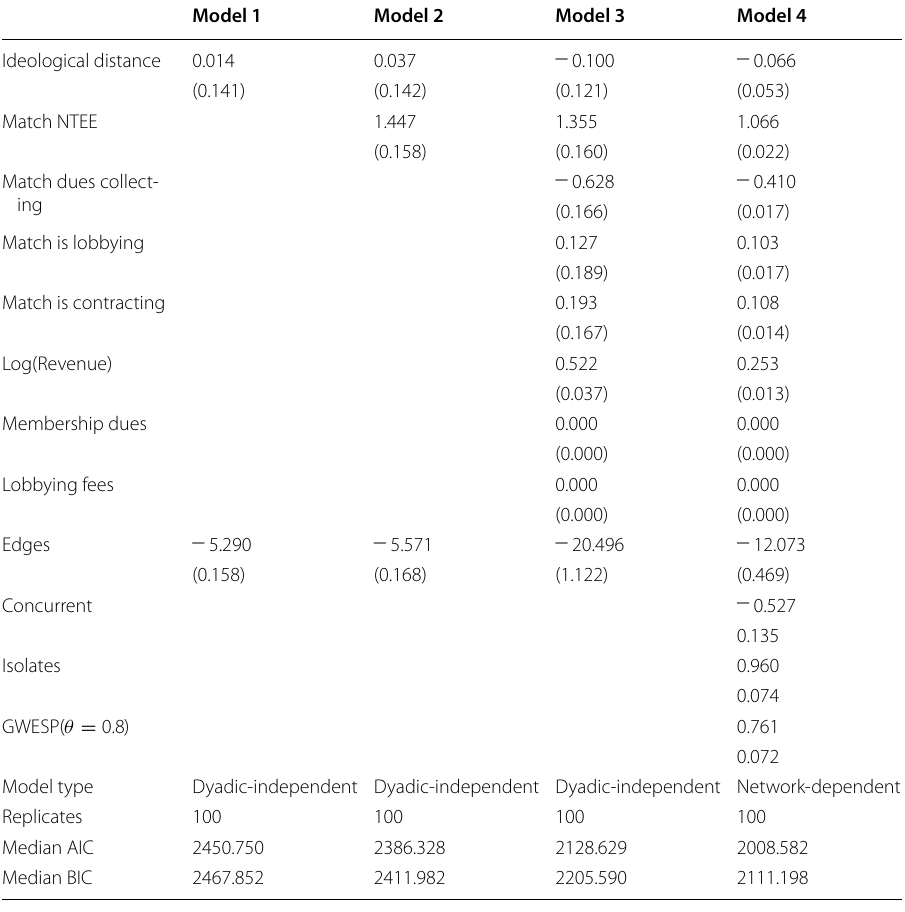
Table 4 Results from ERGMs run on 100 datasets with imputed